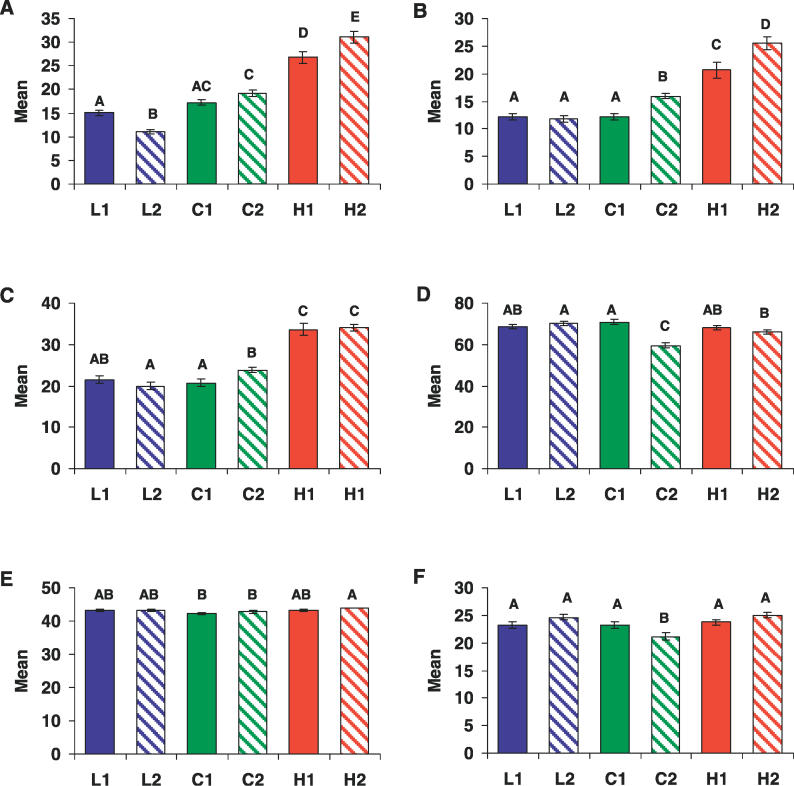
Correlated Phenotypic Responses to SelectionAll scores are pooled across three successive generations. Lines with the same letter are not significantly different from one another at p < 0.05.(A) Male aggression in eight-fly assay.(B) Female aggression in eight-fly assay, after a 90-min food deprivation period.(C) Female aggression in eight-fly assay, after a 120-min food deprivation period.(D) Starvation stress resistance.(E) Locomotor reactivity.(F) Climbing behavior.